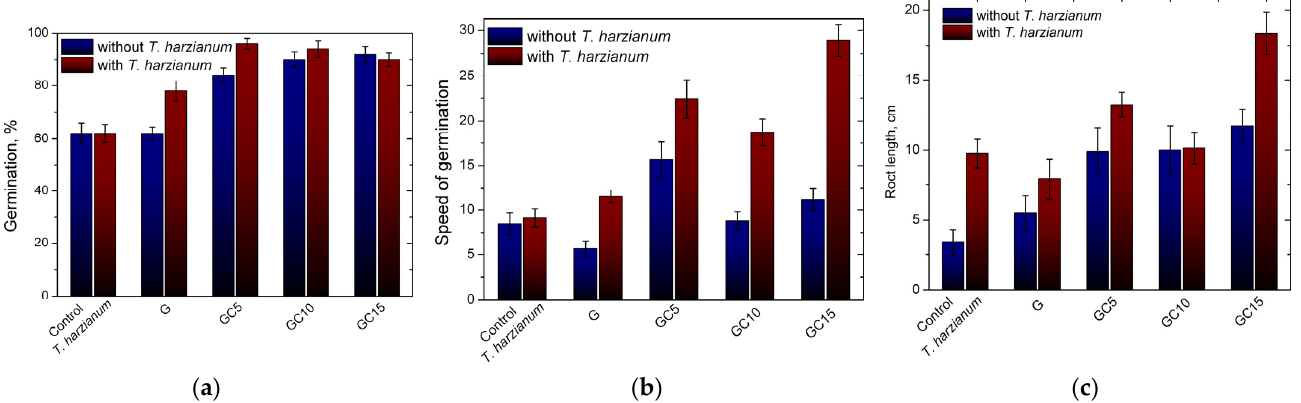
Figure 14. Germination percentage ( a ) speed of germination ( b ) and length of roots ( c ) of coated seeds with and without T. harzianum KUEN 1585 after 7 days of germination .